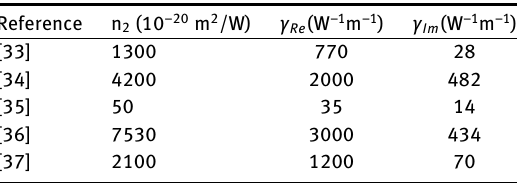
Table 2. The characteristics of several nonlinear a-Si:H waveguides reported in